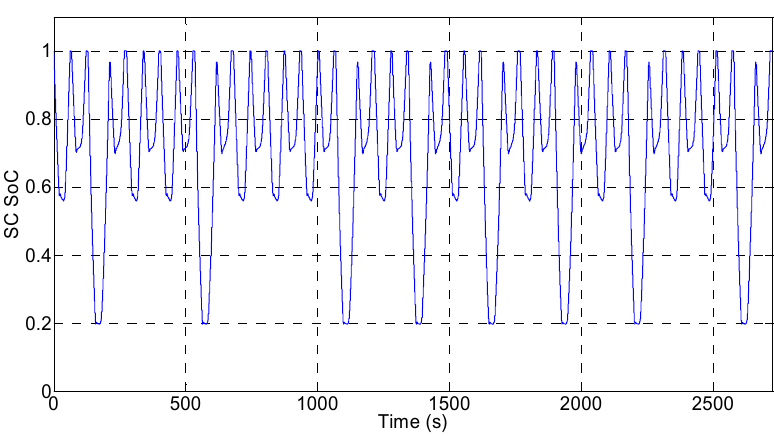
Figure 14. SoC of the SC under continuous work conditions.